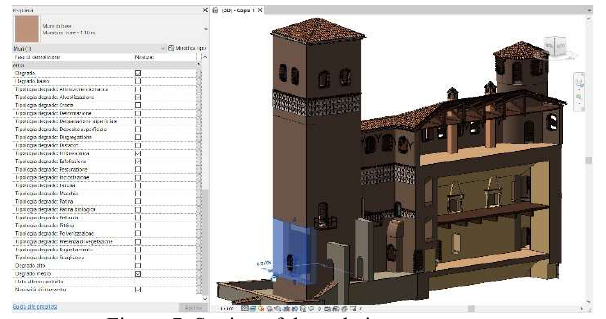
Figure 7. Setting of degradation parameters